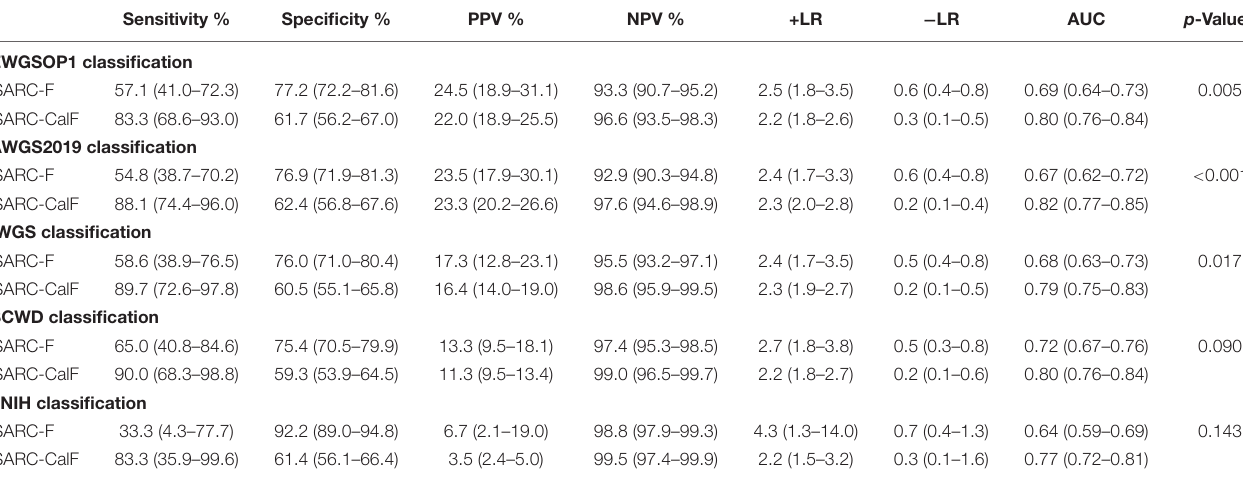
TABLE 7 | Sensitivity, specificity, PPV, NPV, +LR, and − LR assessments and ROC curves for SARC-F and SARC-CalF validation against various criteria of sarcopenia in the group comprising of the younger group. Sensitivity